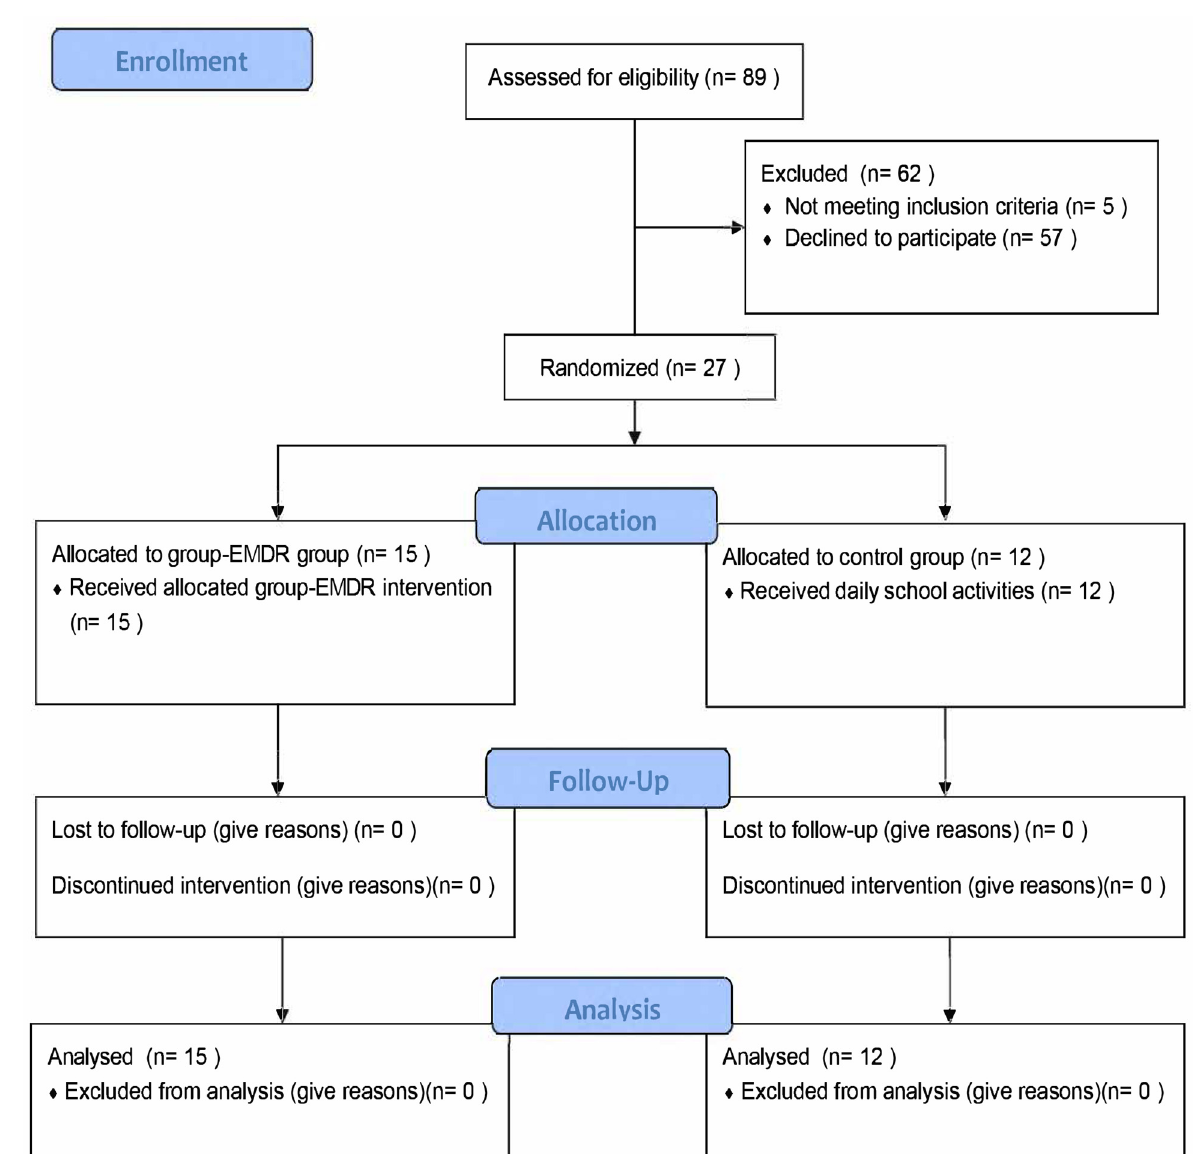
Figure 1. CONSORT flow diagram of the study.